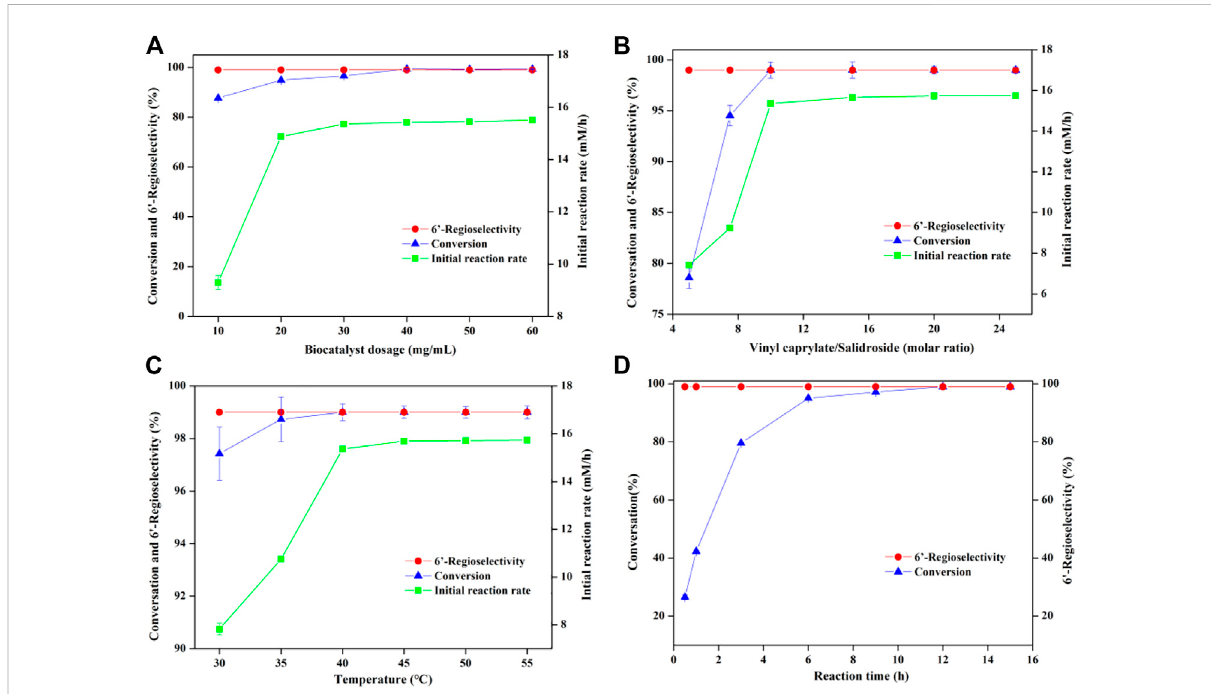
FIGURE 1 Regioselective caproylation of salidroside catalyzed by Aspergillus oryzae cells. (A) Effect of biocatalyst dosage [0.04 mmol salidroside, 0.4 mmol vinyl caprylate, 2 ml anhydrous acetone, 40 ° C, 200 rpm]. (B) Effect of molar ratio [0.04 mmol salidroside, 0.06 g. Aspergillus oryzae cells, 2 mlanhydrousacetone,40 ° C,200 rpm]. (C) Effectoftemperature[0.04 mmolsalidroside,0.4 mmolvinylcaprylate,0.06 g. Aspergillusoryzae cells, 2 mlanhydrousacetone,200 rpm]. (D) Effectofreactiontime[0.04 mmolsalidroside,0.4 mmolvinylcaprylate,0.06 g. Aspergillusoryzae cells,